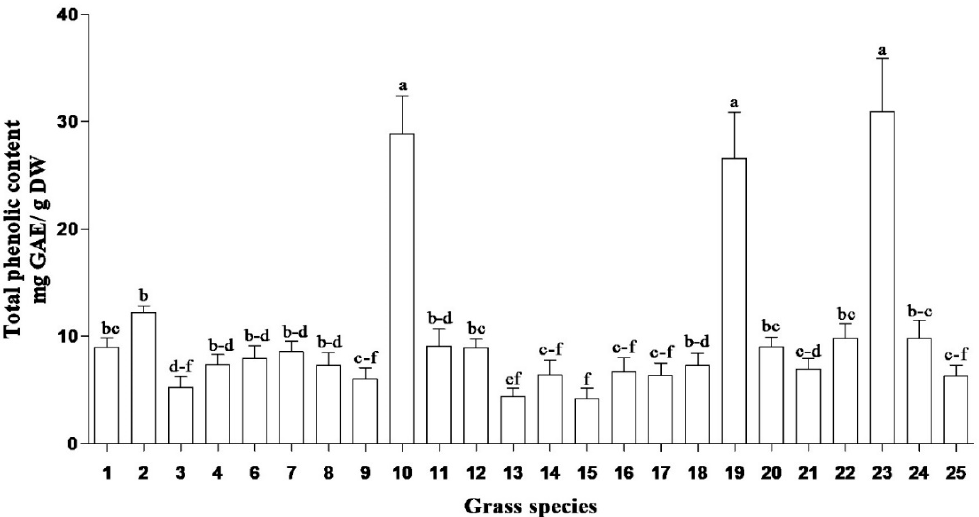
Figure 1. Total soluble phenolic content (mg GAE/g DW) in grass species used in South African traditional medicine. GAE = gallic acid equivalents; DW = dry weight. Bar represents mean ± standard error, n = 3. Bars with different letter(s) are significantly ( p ≤ 0.05) different based on Duncan’s multiple range test (DMRT). (1) Coix lacryma-jobi Roots, (2) Coix lacryma-jobi Leaves, (3) Eragrostis curvula Roots, (4) Eragrostis curvula Leaves, (6) Setaria megaphylla Roots, (7) Setaria megaphylla Leaves, (8) Vetiveria zizanioides Roots, (9) Vetiveria zizanioides Leaves, (10) Cymbopogon nardus Roots, (11) Cymbopogon nardus Leaves, (12) Cymbopogon nardus Inflorescence, (13) Sporobolus pyramidalis Roots, (14) Sporobolus pyramidalis Leaves, (15) Sporobolus africanus Roots, (16) Sporobolus africanus Leaves, (17) Imperata cylindrical Roots, (18) Imperata cylindrical Leaves, (19) Cenchrus ciliaris Roots, (20) Cenchrus ciliaris Leaves, (21) Panicum maximum Roots, (22) Panicum maximum Leaves, (23) Cymbopogon spp. Roots, (24) Cymbopogon spp. Leaves and (25) Cynodon dactylon whole plant.